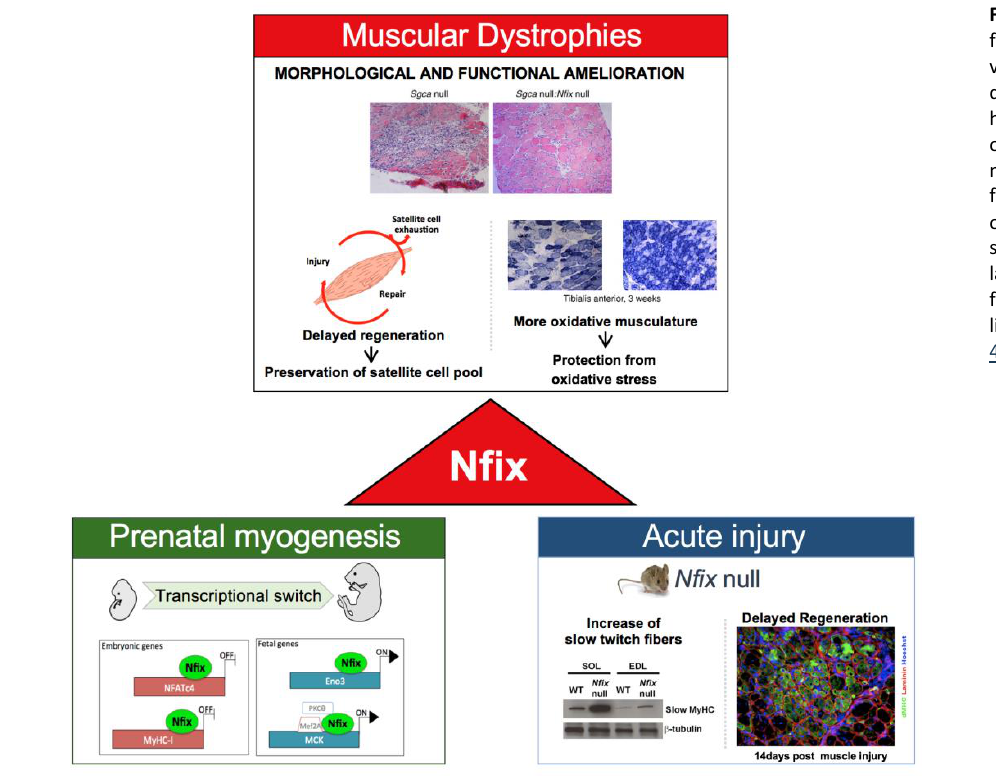
FIGURE 1: Scheme of Nfix functions in muscle de- velopment and muscular dystrophy, highlighting how basic biology studies on pre- and